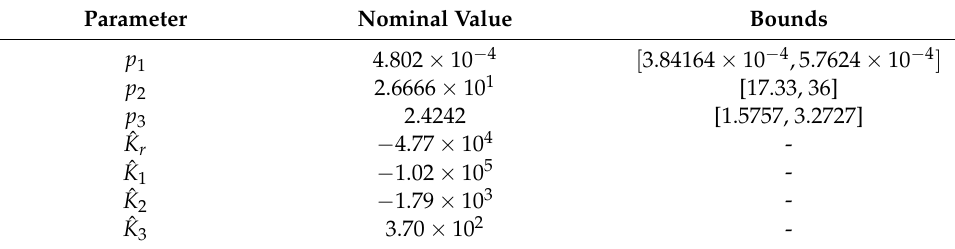
Table 3. Nominal values of parameters and feedback